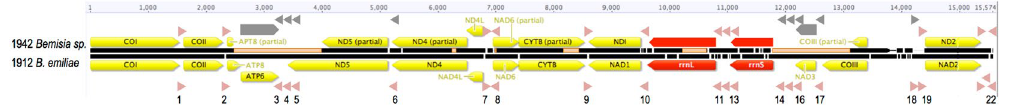
Figure 1. Diagrammatic representation of the complete mitochondrial DNA genome of Bemisia emiliae (black bar), showing orientation of protein coding genes (PCGs), tRNAs and rRNAs, with the mitochondrial DNA cytochrome oxidase (mtCOI) gene arbitrarily selected as a starting point. The mitochondrial DNA genome of the 1942 Japanese Bemisia sp. is aligned against that of B . emiliae , and gaps are introduced for alignment purposes. Predicted tRNAs, and partial PCGs of the 1942 Bemisia sp. are as detailed in Supplementary Table 1. Missing tRNAs and PCGs are shown in grey with corresponding orange segments on the mtDNA genome schematic diagram of the 1942 Bemisia